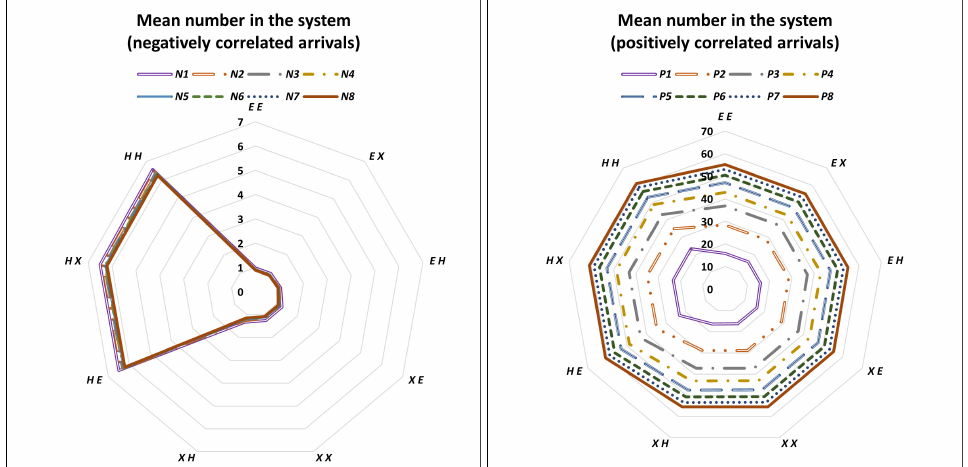
Figure 5. Mean number of customer in the system for negatively correlated and positively correlated arrivals (Model